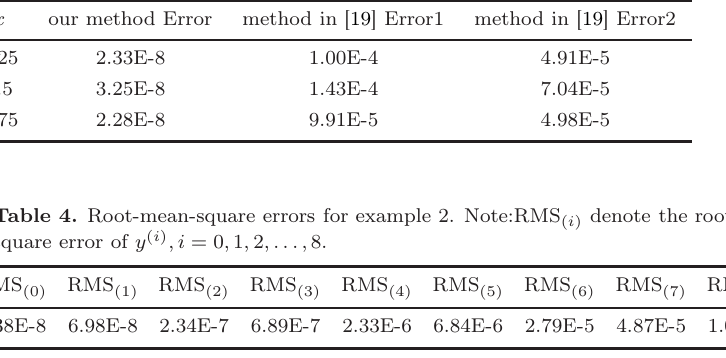
Table 3. Absolute errors for Example 2.